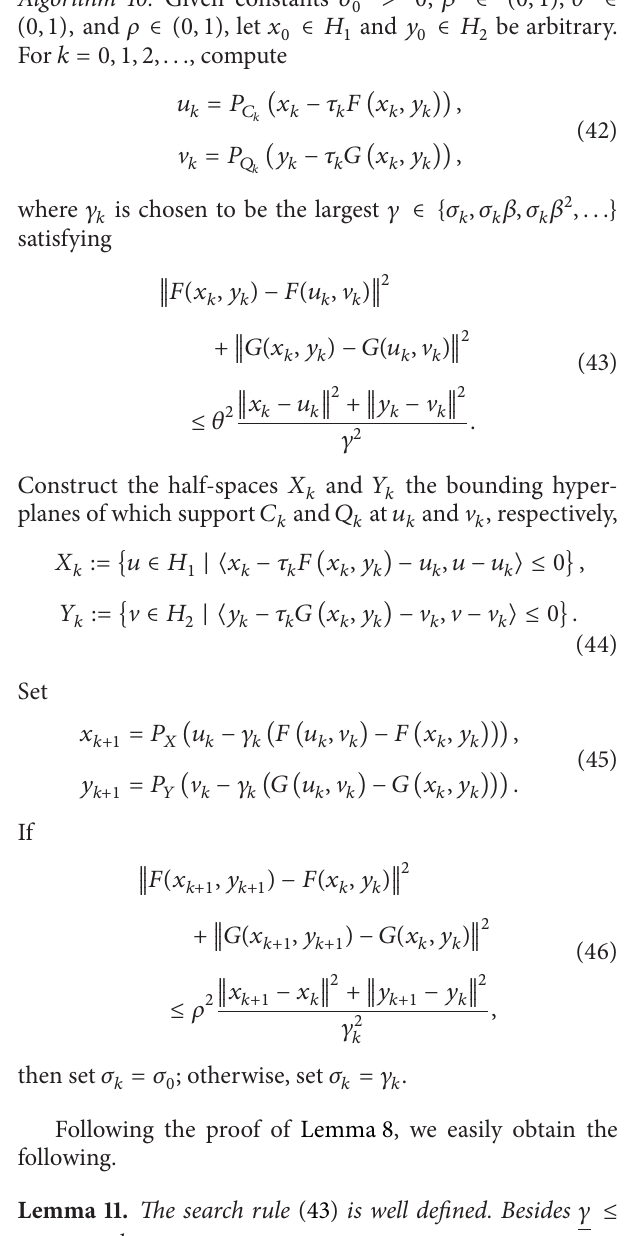
Algorithm 10. Given constants 𝜎 0 > 0 , 𝛽 ∈ (0, 1) , 𝜃